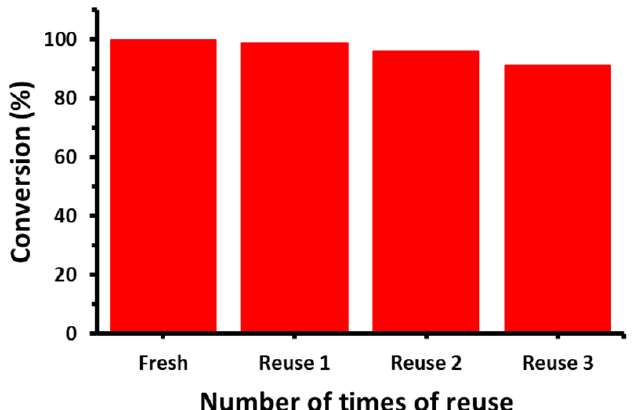
Figure 14. Graphical representation of the conversion product obtained by the reuse of the catalyst for the catalytic conversion of iodobenzene.